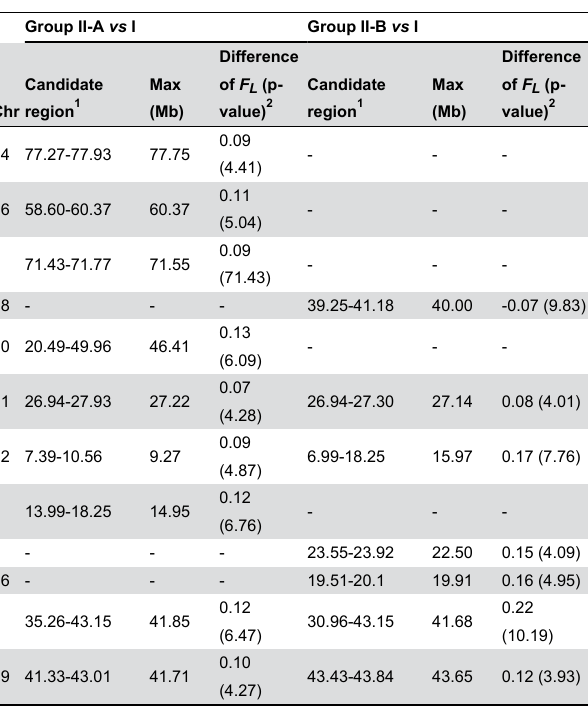
) between selected and L